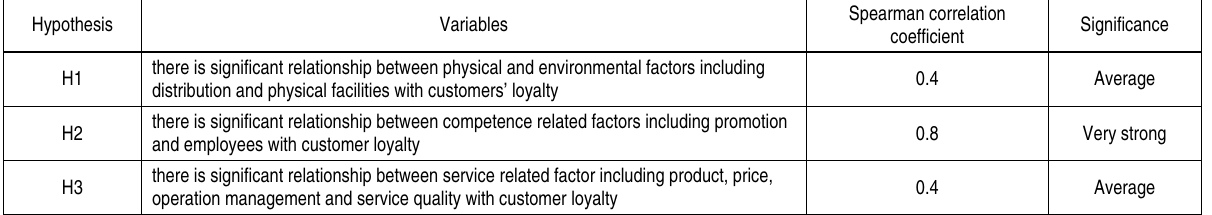
Table 1. Results obtained by hypotheses analysis using Spearman correlation coefficient